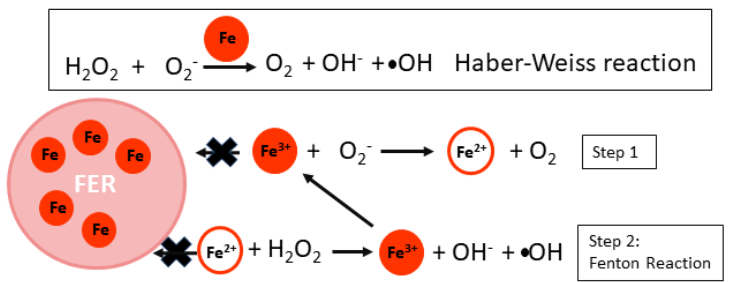
Figure 4. Role of Ferritin (FER) in preventing Haber–Weiss and Fenton reactions that can perpetuate the production of reactive oxygen species (ROS). FER is expressed under normal conditions to prevent accumulation of free Fe and avoid excessive build up of ROS. If FER cannot capture free Fe, Haber–Weiss reactions, which are catalyzed by free Fe, can lead to the build up of hydroxyl radicals ( • OH). These reactions occur in two steps. First, Fe 2 + and oxygen are produced from Fe 3 + and superoxide. Second, the Fe 2 + can react with hydrogen peroxide (H2O2) to produce Fe 3 + and harmful hydroxyl radicals in a Fenton reaction.